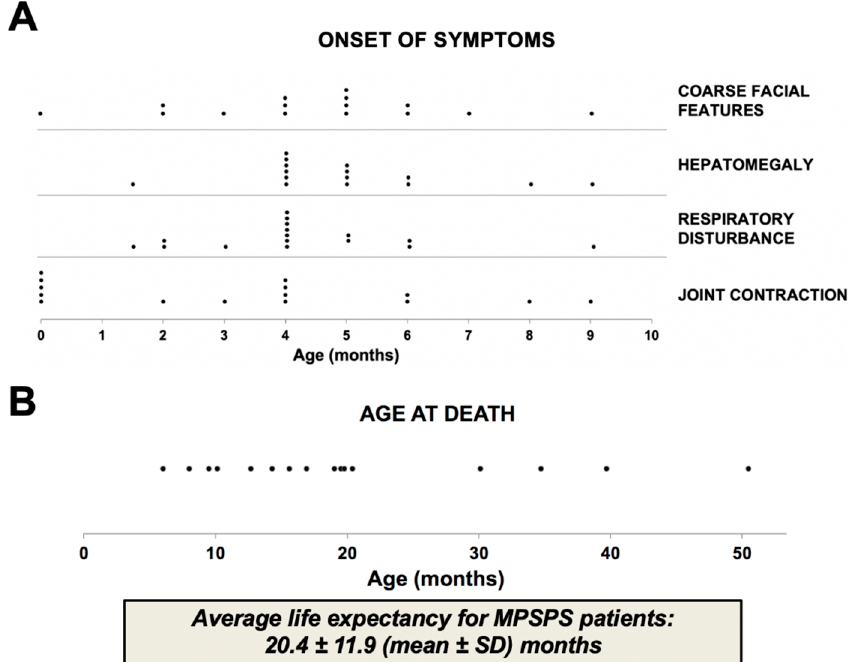
Figure 3. Onset of clinical features and life expectancy of MPSPS patients. Data from sixteen MPSPS patients from Yakutia (Russia). ( A ) Symptoms of disease usually occur between the ages of 2–6 months. ( B ) Most of patients died of cardiorespiratory failure at age of 10–20 months. Each dot indicates one MPSPS patient.